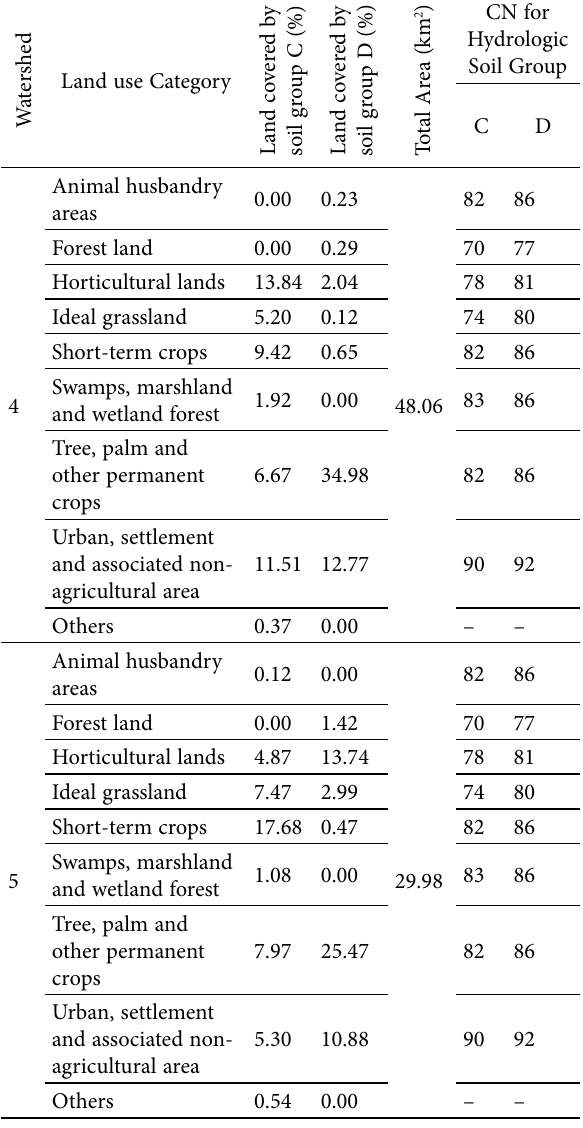
Table 4. Weighted CN